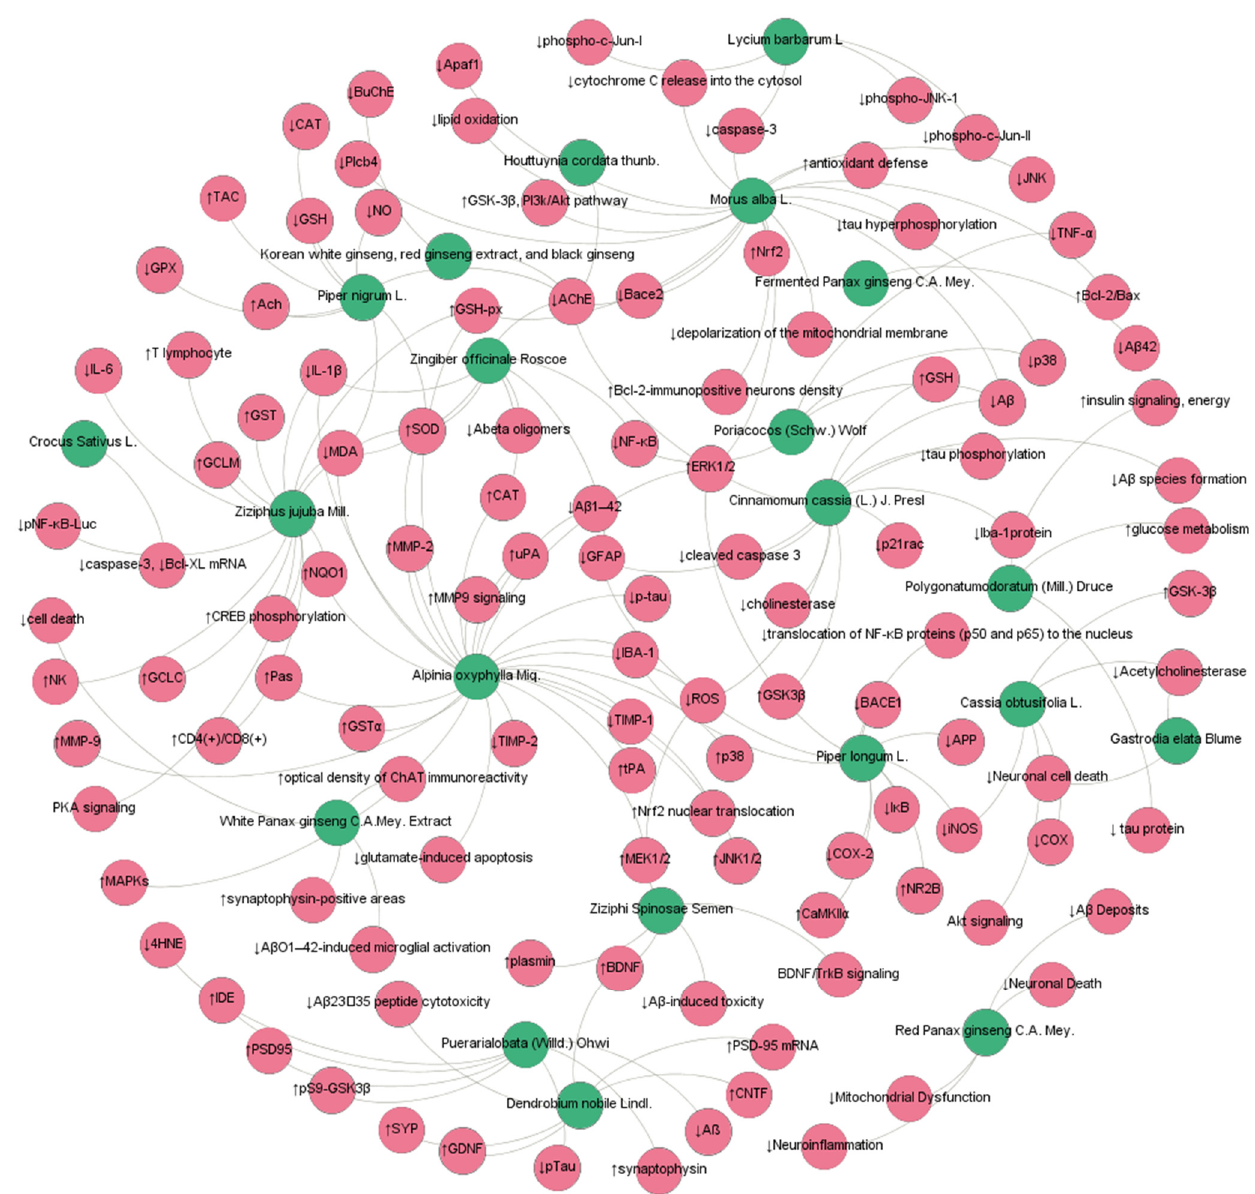
Figure 1. MFH antiAD network mechanism diagram. (Blue nodes represent MFH, and red nodes represent targets/pathways).